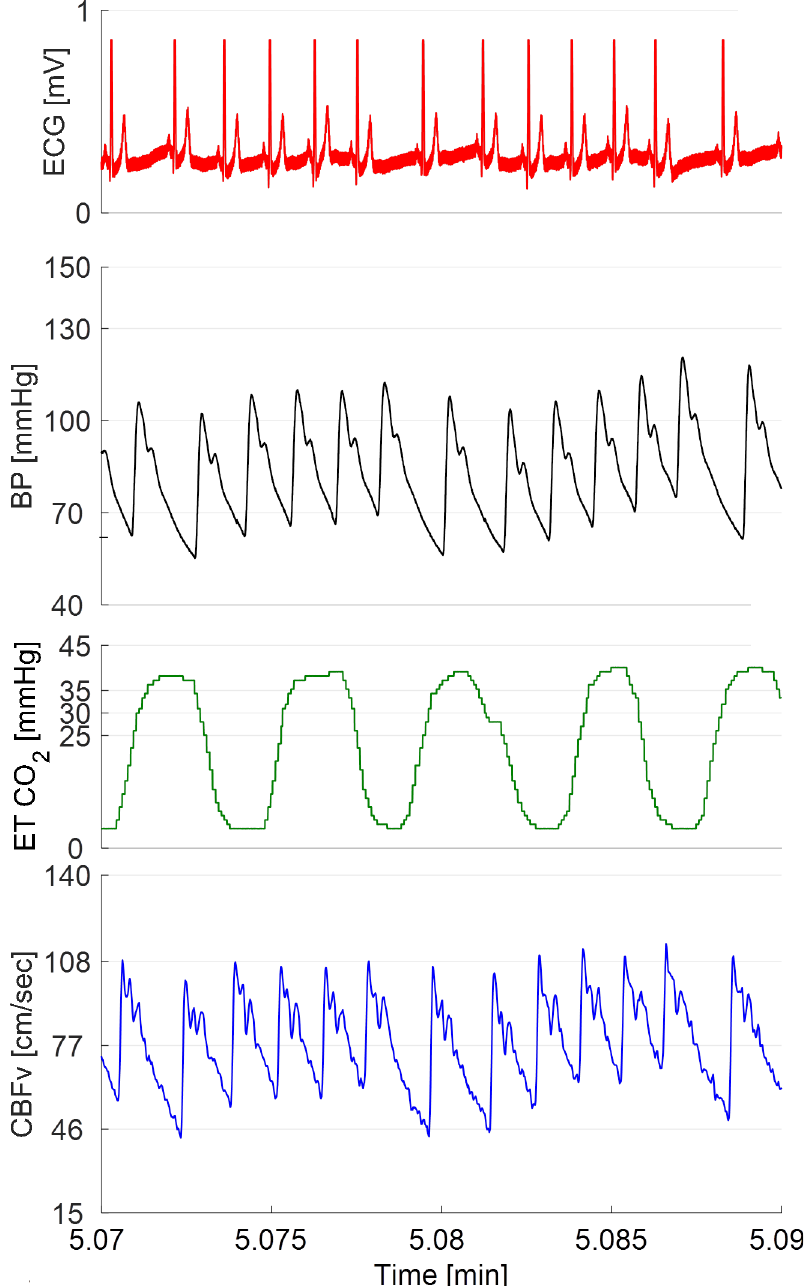
Fig 1. Example of continuous raw data. From top to bottom: electrocardiogram, beat-to-beat blood pressure, end tidal CO 2 and cerebral blood flow